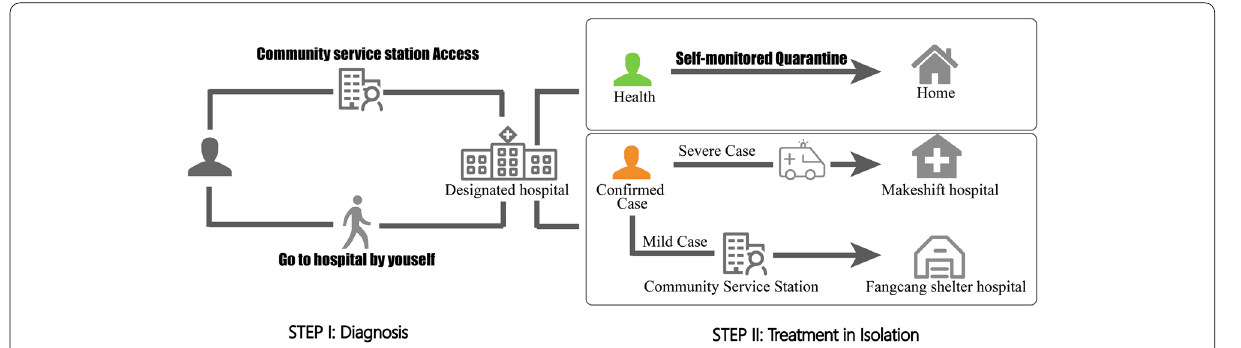
Fig. 1 The medical treatment process during the COVID-19 epidemic in